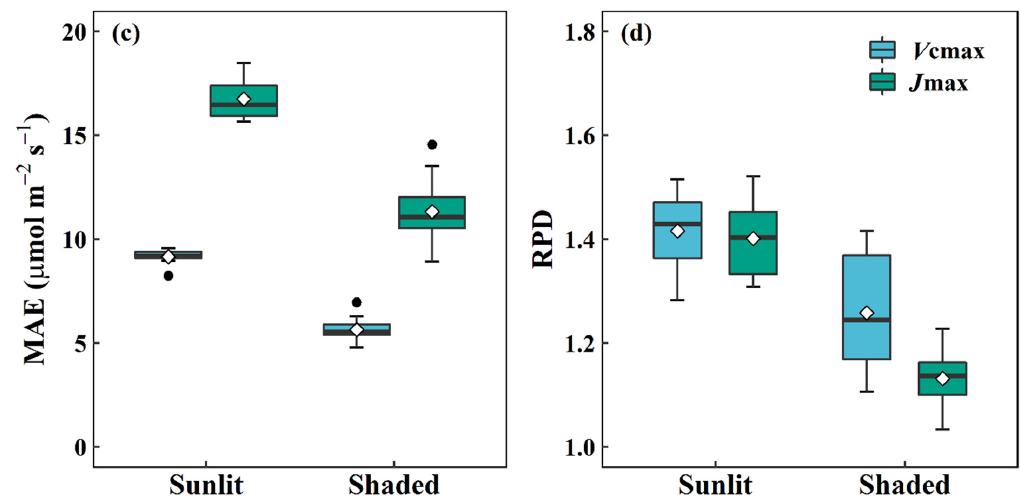
Figure 4. The statistical distributions of R 2 ( a ), RMSE ( b ), MAE ( c ), and RPD ( d ) for predicting the maximum carboxylation rate ( V cmax) and maximum electron transport ( J max) in sunlit and shaded leaves using the ensemble DNN model. R 2 : coefficient of determination; RMSE: root mean square error; MAE: mean absolute error; RPD: ratio of performance to standard deviation.